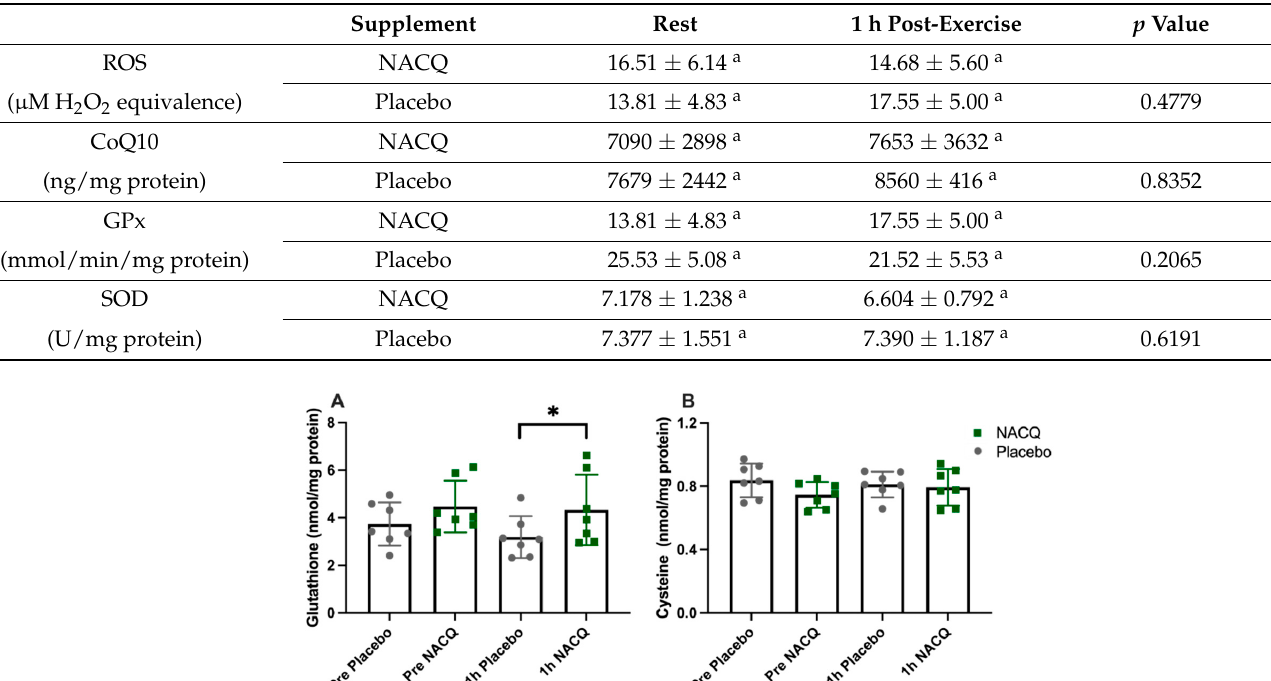
Table 3. Skeletal muscle reactive oxygen species (ROS), coenzyme Q10 (CoQ10) concentrations, and activities of glutathione peroxidase (GPx) and superoxide dismutase (SOD) in NACQ- and placebo-supplemented horses. Differences in super- scripts indicate significant differences with supplementation or exercise. There were no significant effects of exercise or NACQ/placebo supplementation.